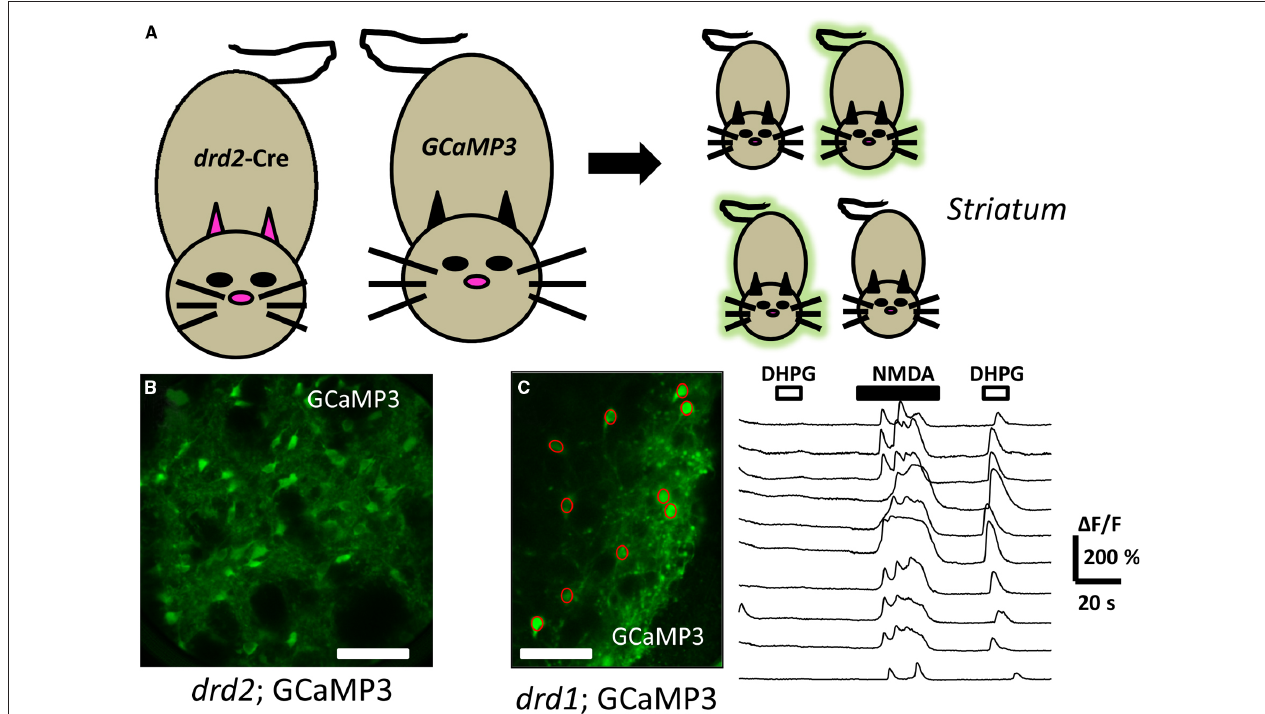
dopamine D2 cells. (C) Live confocal image of an acute striatal brain slice showing drd1 : GCaMP3 expressing neurons (green, left ) with superimposed regions of interest (ROI, red circles ) allowing genetically targeted calcium imaging. To the right are shown the time course of changes in [Ca 2 + ] i ( (cid:49) F/F) in the ROIs corresponding to cell bodies. Each trace represents a different ROI or cell body. The top horizontal bars above the traces represent the time duration that the drugs DHPG (10 µ M, open bars ), or NMDA (20 µ M, filled bars ) were acutely applied. Note the ability to detect GPCR activation following activation of the cells. Scale bars in (B) and (C) : 100 µ